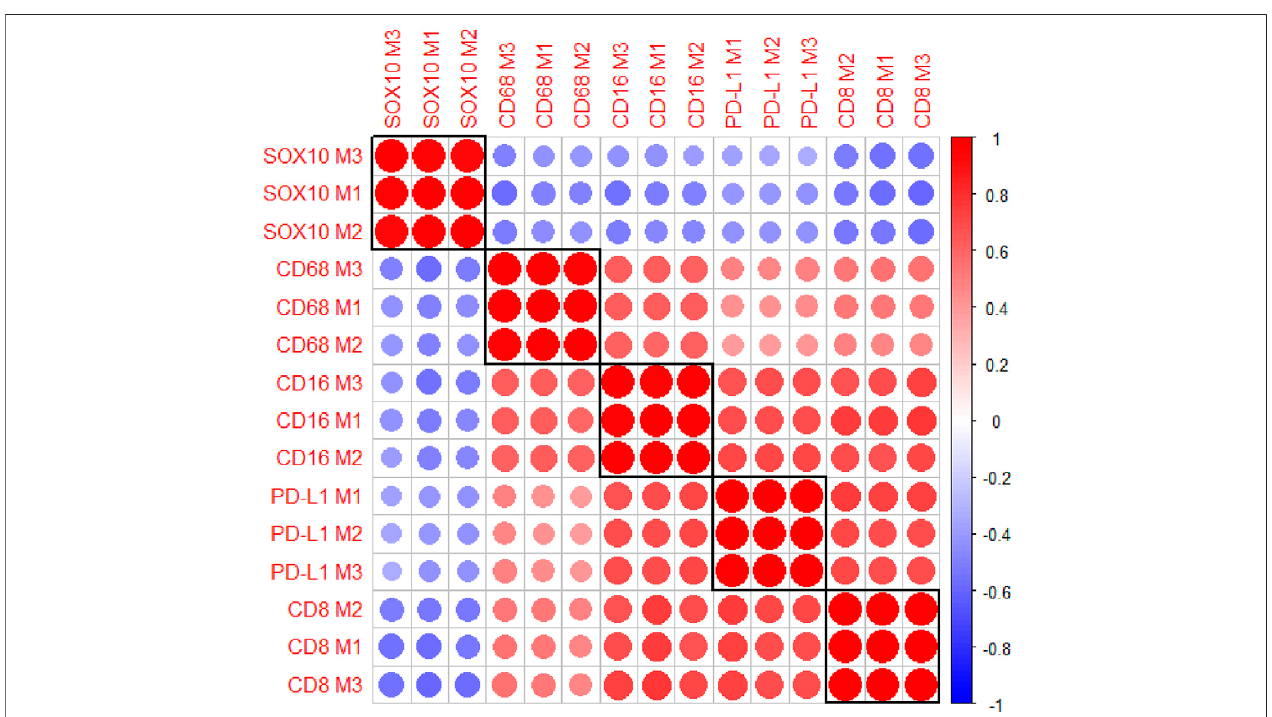
FIGURE 9 | A correlation matrix heatmap comparing the relationship between the cell densities of each marker across the three consecutive multiplex immuno fl uorescence sections. Highly signi fi cant positive correlations were observed between the three Multiplexes for all markers. The strongest correlations were observed for PD-L1 between Multiplex 2 and Multiplex 3. The size of the circles represent the absolute value of the correlation coef fi cient. The colours of the circles represent the sign and magnitude of the correlation with shades of red representing positive and higher correlation coef fi cients and shades of blue representing negative and lower correlation coef fi cients. Data are Spearman ’ s correlation values with p <